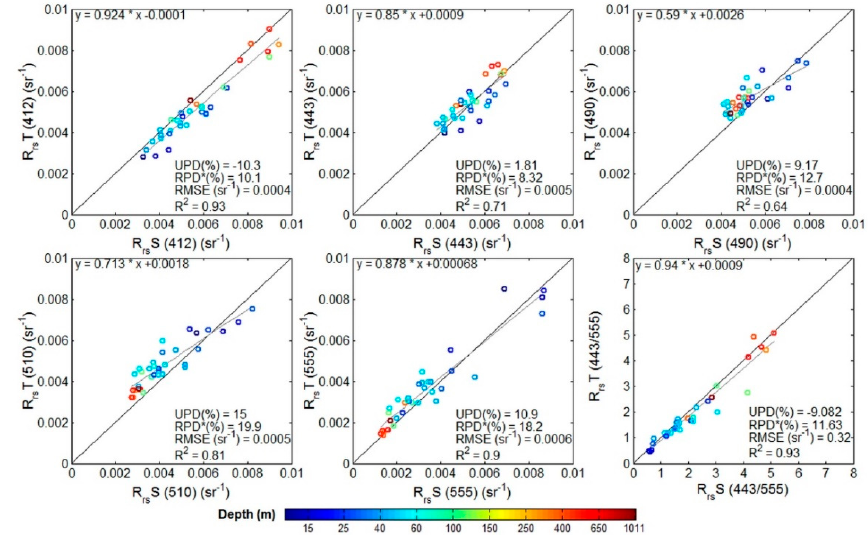
Figure 9. Comparison of Remote sensing reflectance from TriOS radiometer ( R rs T) vs. Remote sensing reflectance from Satlantic radiometer (R rs S) for the ocean colour bands and the 443:555 ratio (Number of samples = 34).